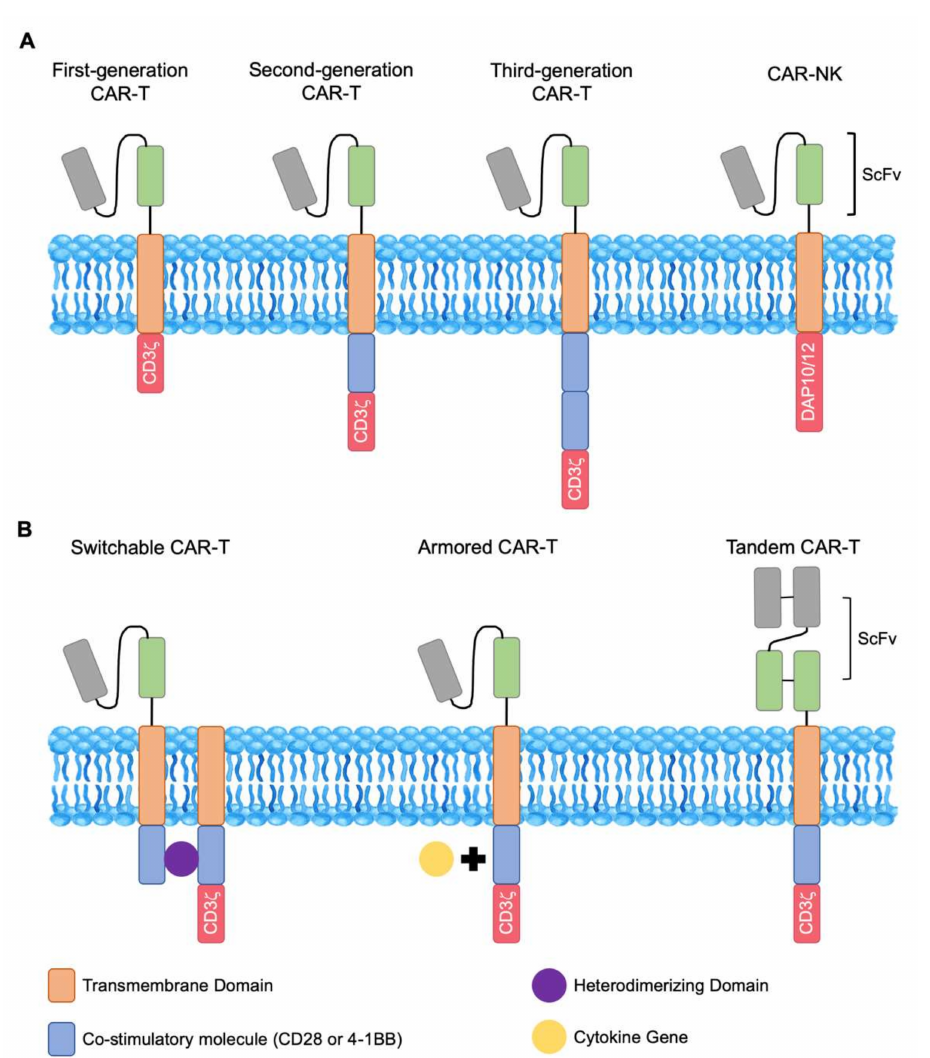
Figure 1. Structures of chimeric antigen receptor (CAR)-T and CAR-natural killer (NK) cells. ( A ) CAR-T cells are engineered by fusing the single-chain variable fragment (scFv) region of a monoclonal antibody to a transmembrane domain and intracellular signaling domains. CAR-NK constructs substitute NK-specific DAP10 or DAP12 protein for CD3 ζ . CARs that contain the CD3 ζ domain are known as first-generation. Second-generation CARs contain CD3 ζ and a co-stimulatory molecule such as CD28 or 4-1BB. Third-generation CARs contain two or more co-stimulatory molecules. ( B ) Switchable CAR-T cells require a heterodimerizing domain as the “on switch” that joins the co-stimulatory domains. Armored CAR-T cells have increased protection against the immunosuppressive tumor microenvironment through the co-expression of cytokines within the CAR-T vector. Tandem CAR-T cells are designed to have two antigen-recognizing domains with one intracellular signaling